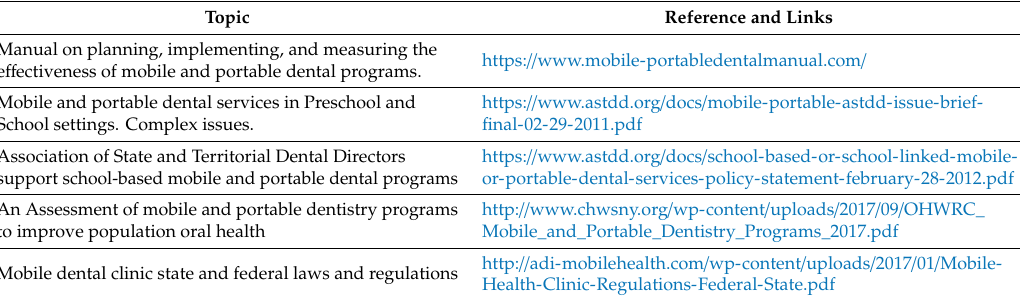
Table 2. Additional resources for those interested in conducting more research on mobile dental clinics and portable dentistry. Topic Reference and Links Manual on planning, implementing, and measuring the https: // www.mobile-portabledentalmanual.com / e ff ectiveness of mobile and portable dental programs. Mobile and portable dental services in Preschool and School settings. Complex